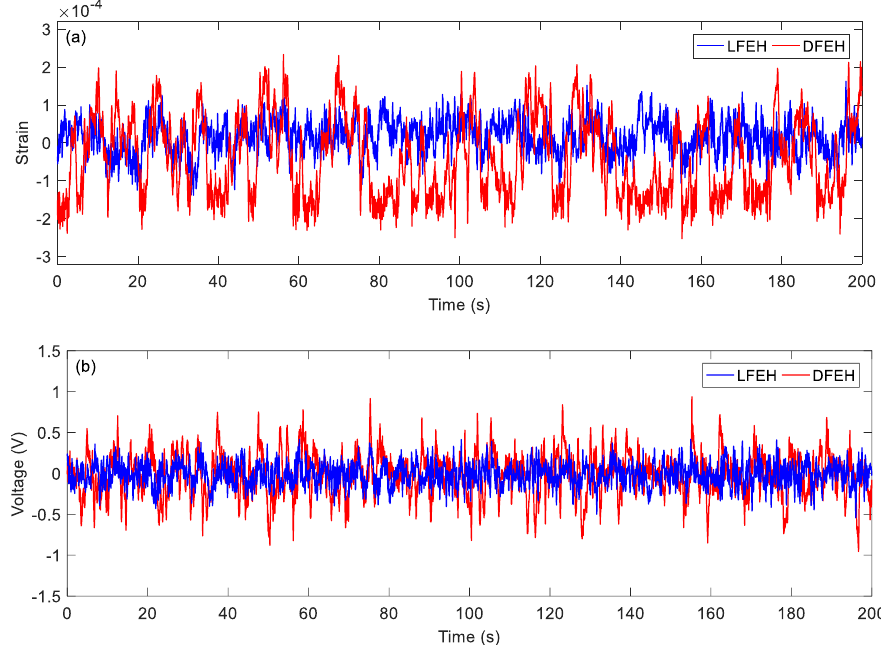
Figure 17. ( a ) Time histories of strain response, ( b ) time histories of voltage response ( v = 6.0 m/s).